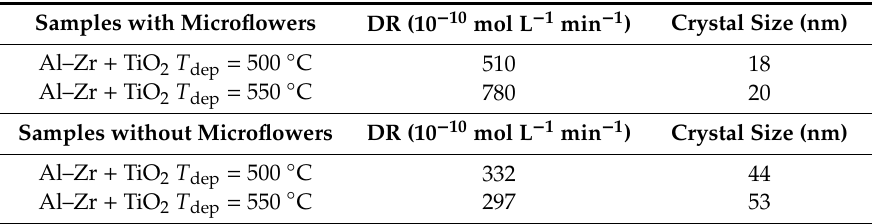
Table 2. The e ff ect of presence of microflowers on the decomposition rate and the crystal size for the TiO 2 / Al–Zr coatings deposited at 500 ◦ C and 550 ◦ C.